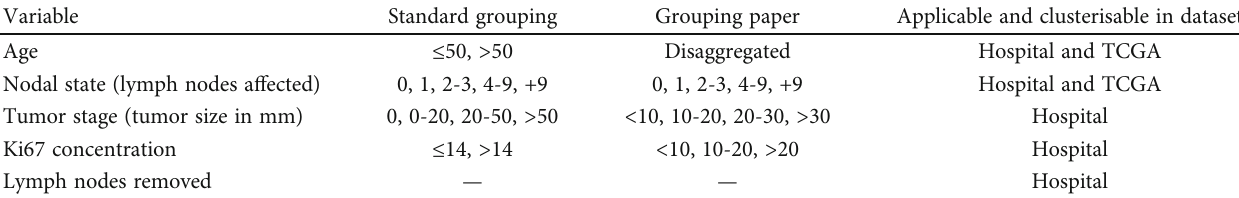
Table 1: Variable numerical